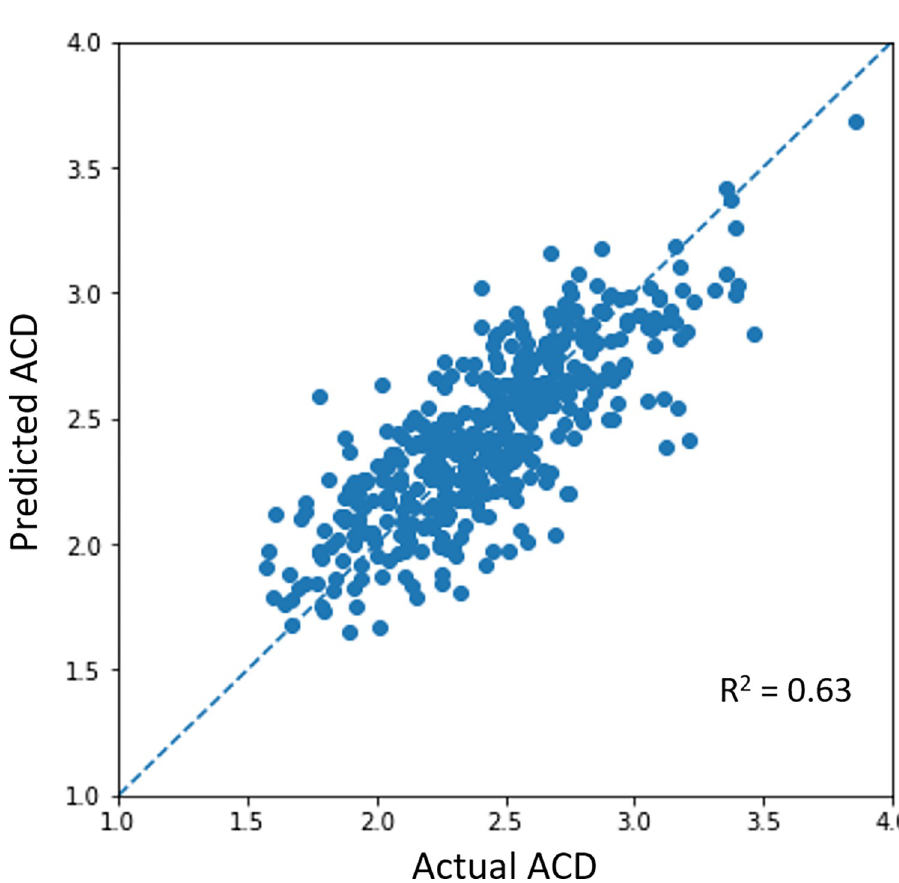
Fig 1. Correlation between actual anterior chamber depth (ACD) measurements and deep learning predicted ACD values in algorithm validation.